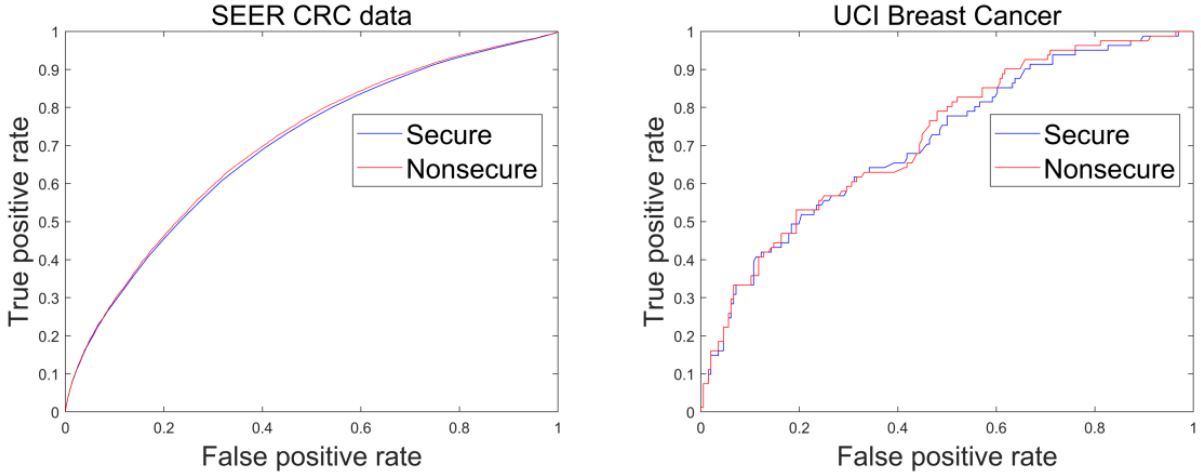
Figure 3. Average receiver operating characteristic curves of nonsecure and proposed secure logistic regressions. CRC: colorectal cancer; ROC: receiver operating characteristic; SEER: surveillance, epidemiology, and end results; UCI: University of California,